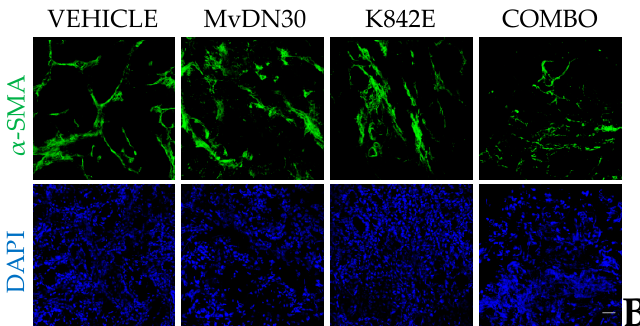
Figure 4. Concomitant MET/HGF targeting induces a reversion of the epithelial-to-mesenchymal transition (EMT) phenotype as well as a decrease of activated α -SMA positive fibroblasts in an orthotopic model of pancreatic cancer. HPAF-II cells were orthotopically injected in SCID mice genetically modified to secrete physiological levels of human HGF (hHGF knock-in); after 2 days, mice were divided into four groups and treated with vehicle, MvDN30 (10 mg/kg), decoyMET K842E (10 mg/kg), or the combination of the two in a 1:1 ratio. Treatments were administered every 2 days by intraperitoneal injection. After 5 weeks of treatment, mice were sacrificed, and primary tumors were collected and processed for an immunofluorescence analysis. ( A ) E-cadherin and vimentin staining. Bar is 50 µ m. ( B ) α -SMA staining. Bar is 50 µ